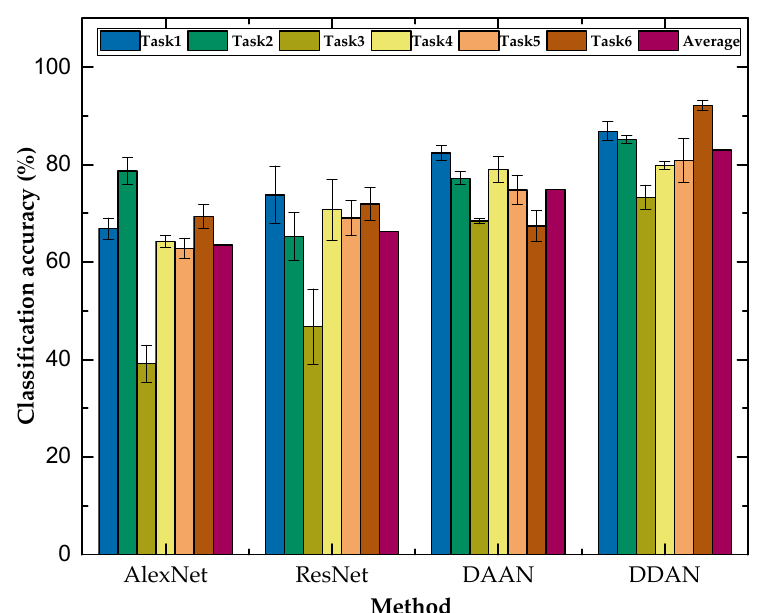
Figure 9. Classification accuracy (%) on the TCM dataset with six transfer tasks. Figure 10 reflects the average standard deviation of each method for the six transfer